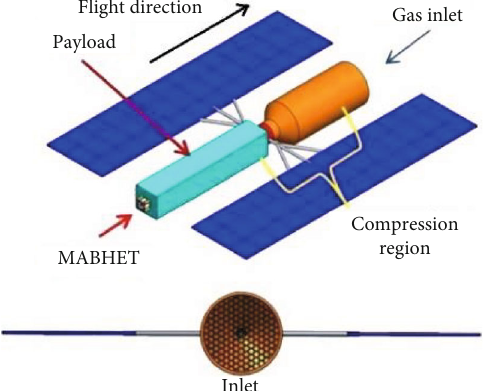
Figure 16: Conceptual MABHET of BUSEK